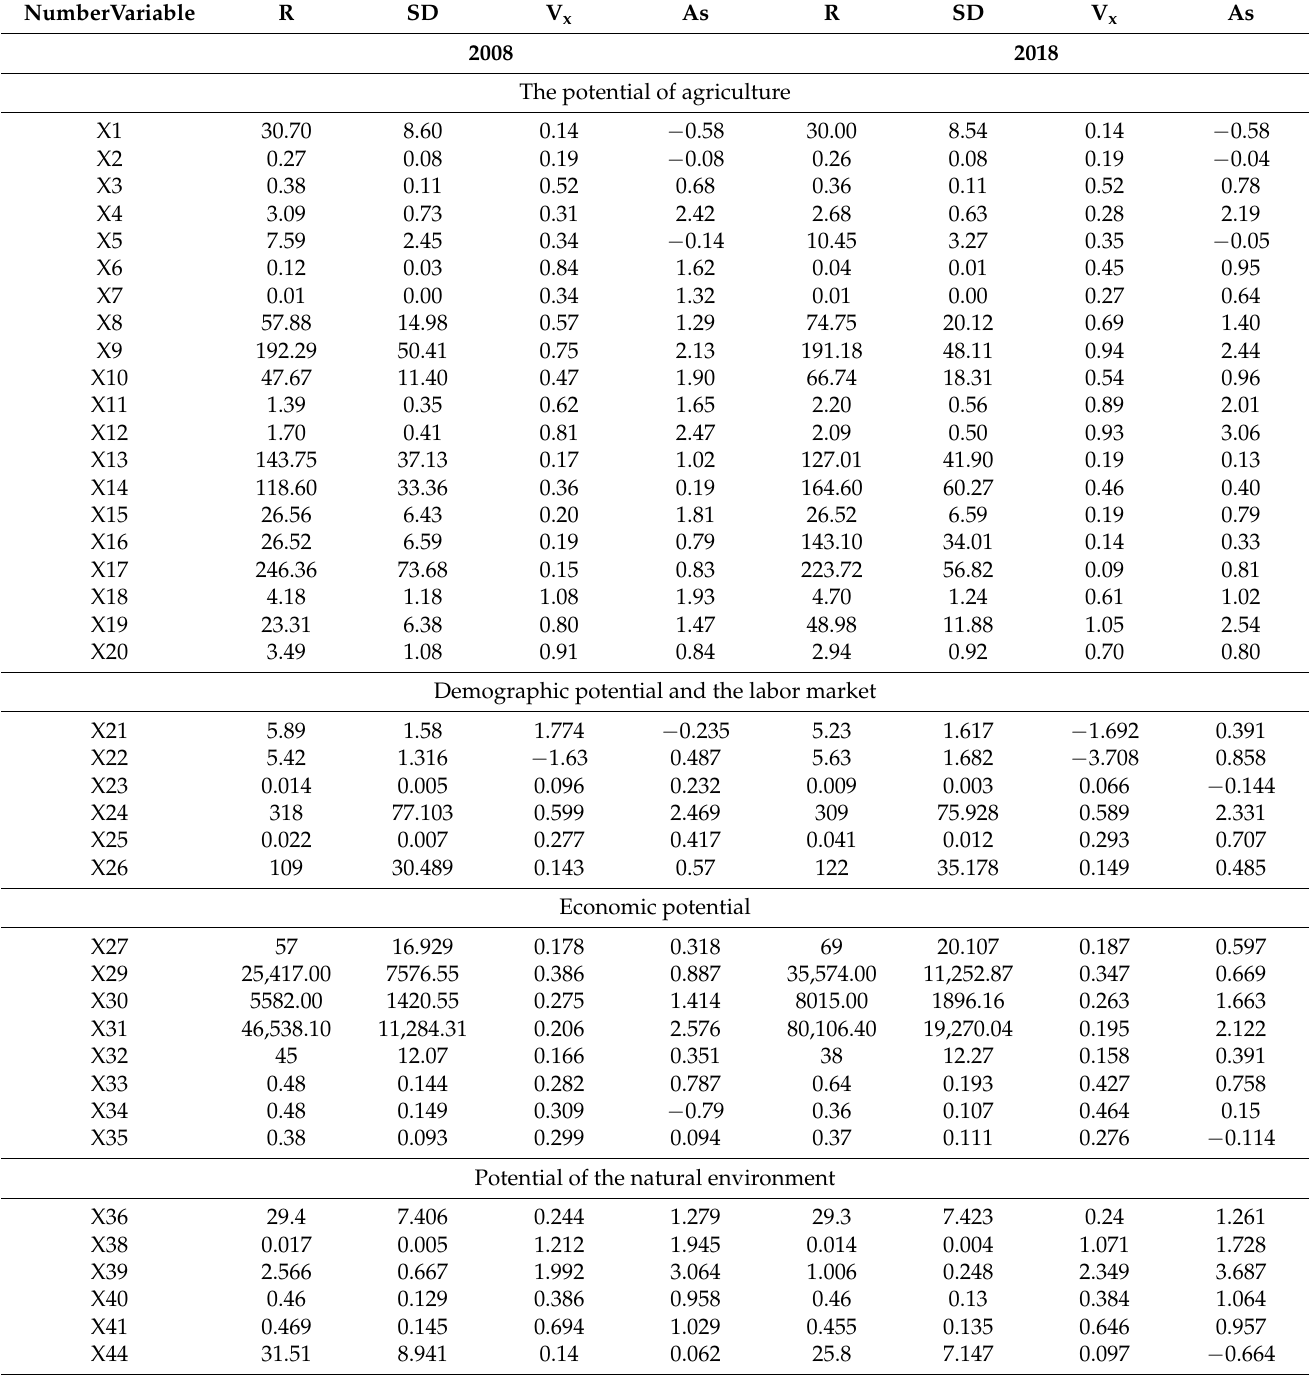
Table 2. Statistical characteristics of diagnostic variables in eastern Polish